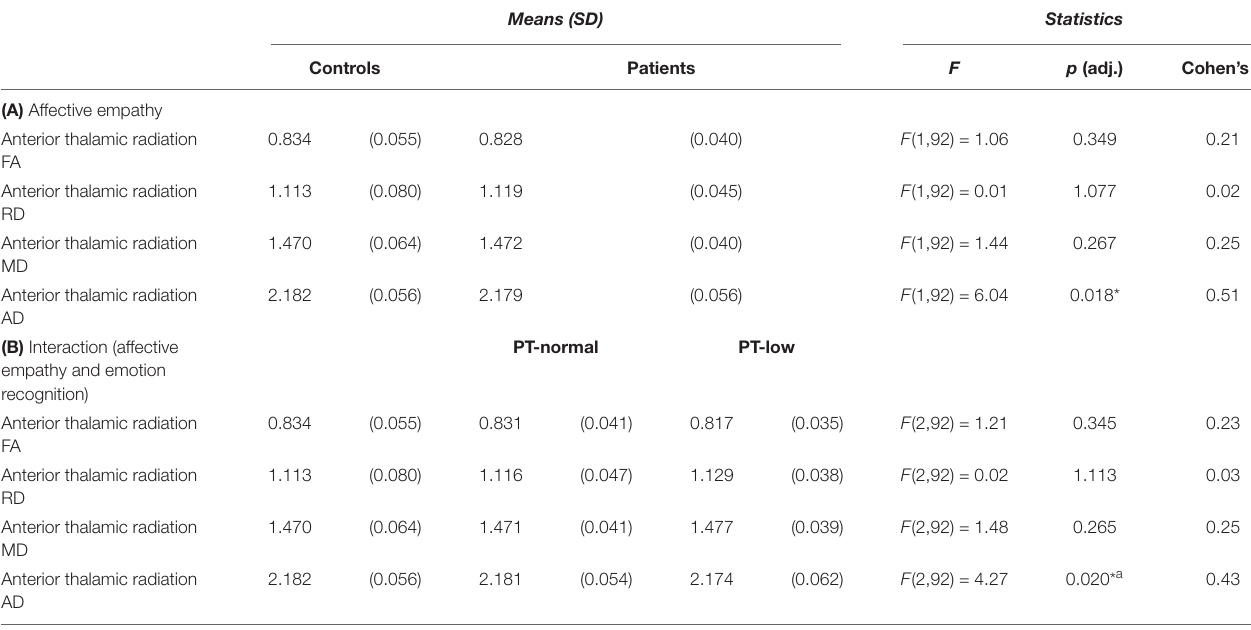
TABLE 2 | Information on the association between affective empathy and measures of white matter diffusivity for (A) patients with schizophrenia and controls and for (B) patients with lower performance on emotion recognition, patients with normal emotion recognition and